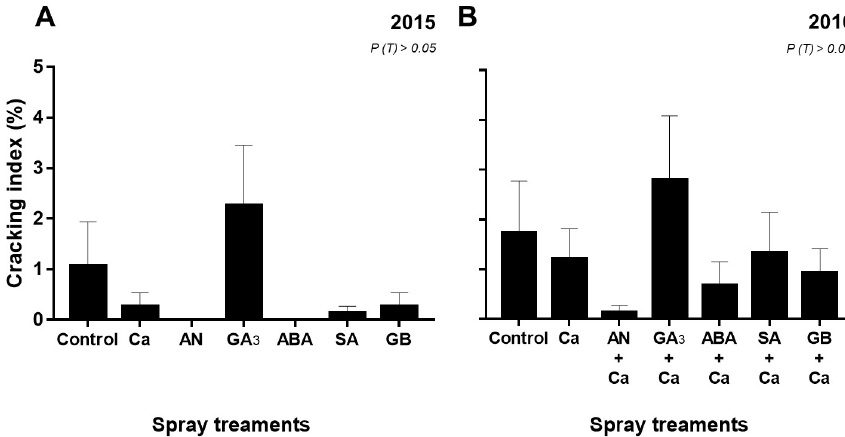
Figure 5. Cracking index (%) of ‘Skeena’ fruits after spray treatments application in 2015 ( A ) and 2016 ( B ). Each column is expressed as mean ± SE (n = 3, each with 50 fruits).